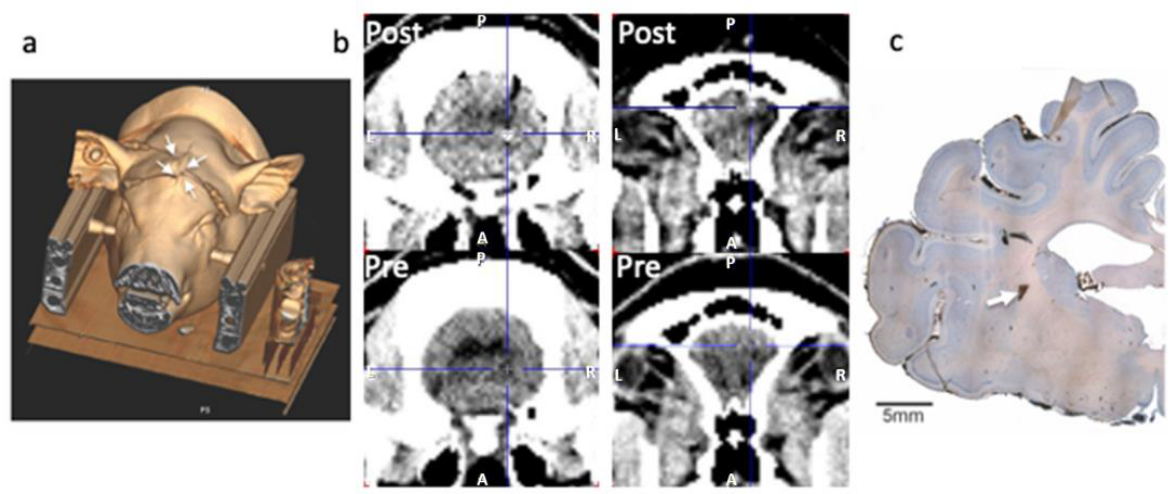
Figure 1. Examples of methods used for validating the animal procedure and location of the micro- dialysis probes. Three-dimensional reconstruction of the animal in the head holder in the PET/CT gantry, obtained from the CT scan used for attenuation correction ( a ). The head of the animal is securely fixed in the stereotaxic headholder and the animal is advanced in the scanner in a prone position. The microdialysis probes can be seen exiting the closed midline incision (four white arrows) for connection to the pump and collecting vials on ice placed outside of the gantry for easy collection of the samples every 10 min. Two examples of probe location are shown in ( b ): the bottom row shows pre-implant CTs at the level of thalamus and frontal cortex. The top row shows the corresponding post-implant-pre-PET CTs with the gold tip target indicated by the cross hair as a white dot in the top image. An example of poor striatal location of the gold tip of the dialysis probe is shown in ( c ). In this image, the tip location (white arrow) appears to be in the internal capsule, between caudate and putamen. This image, covering an entire hemisphere of the pig brain, is a combination of the 40–50 microphotographs merged in Photoshop software.